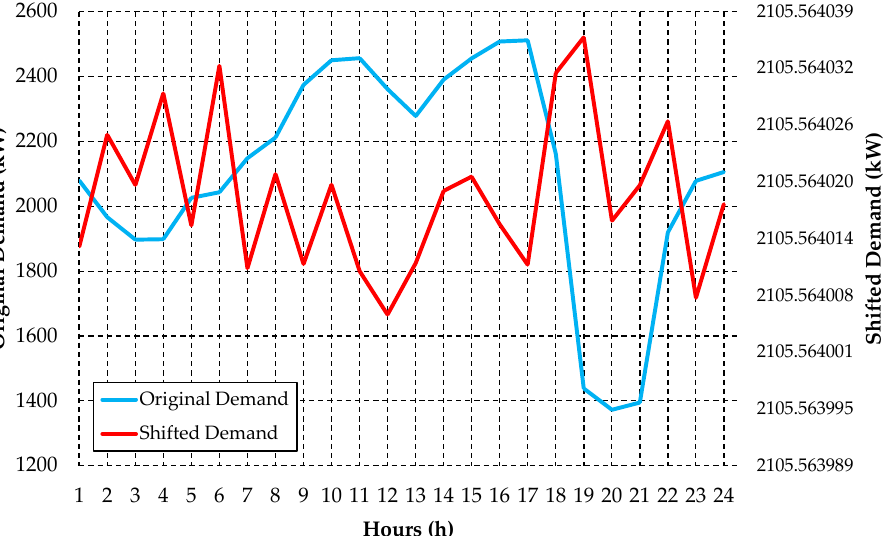
Figure 26. Comparison of the original and shifted demand profiles for Rural Feeder C. Source: The authors.